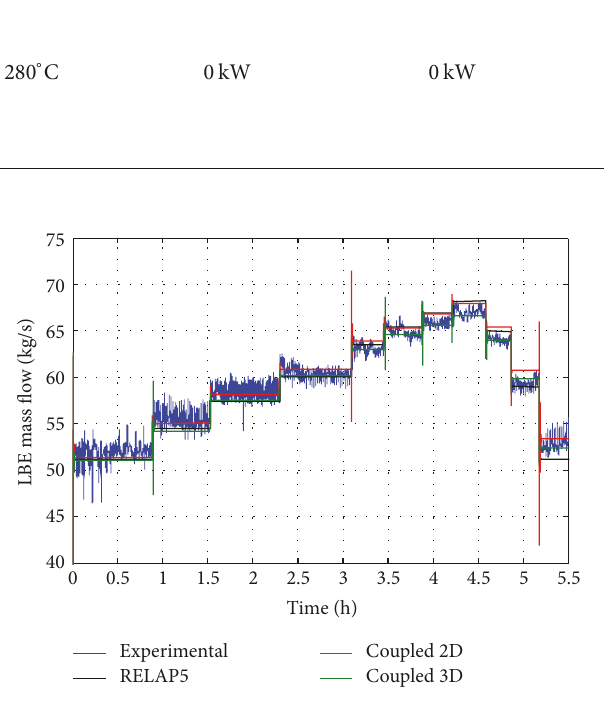
Figure 12: Time trend of the LBE mass flow rate for Test F400 in CIRCE facility.